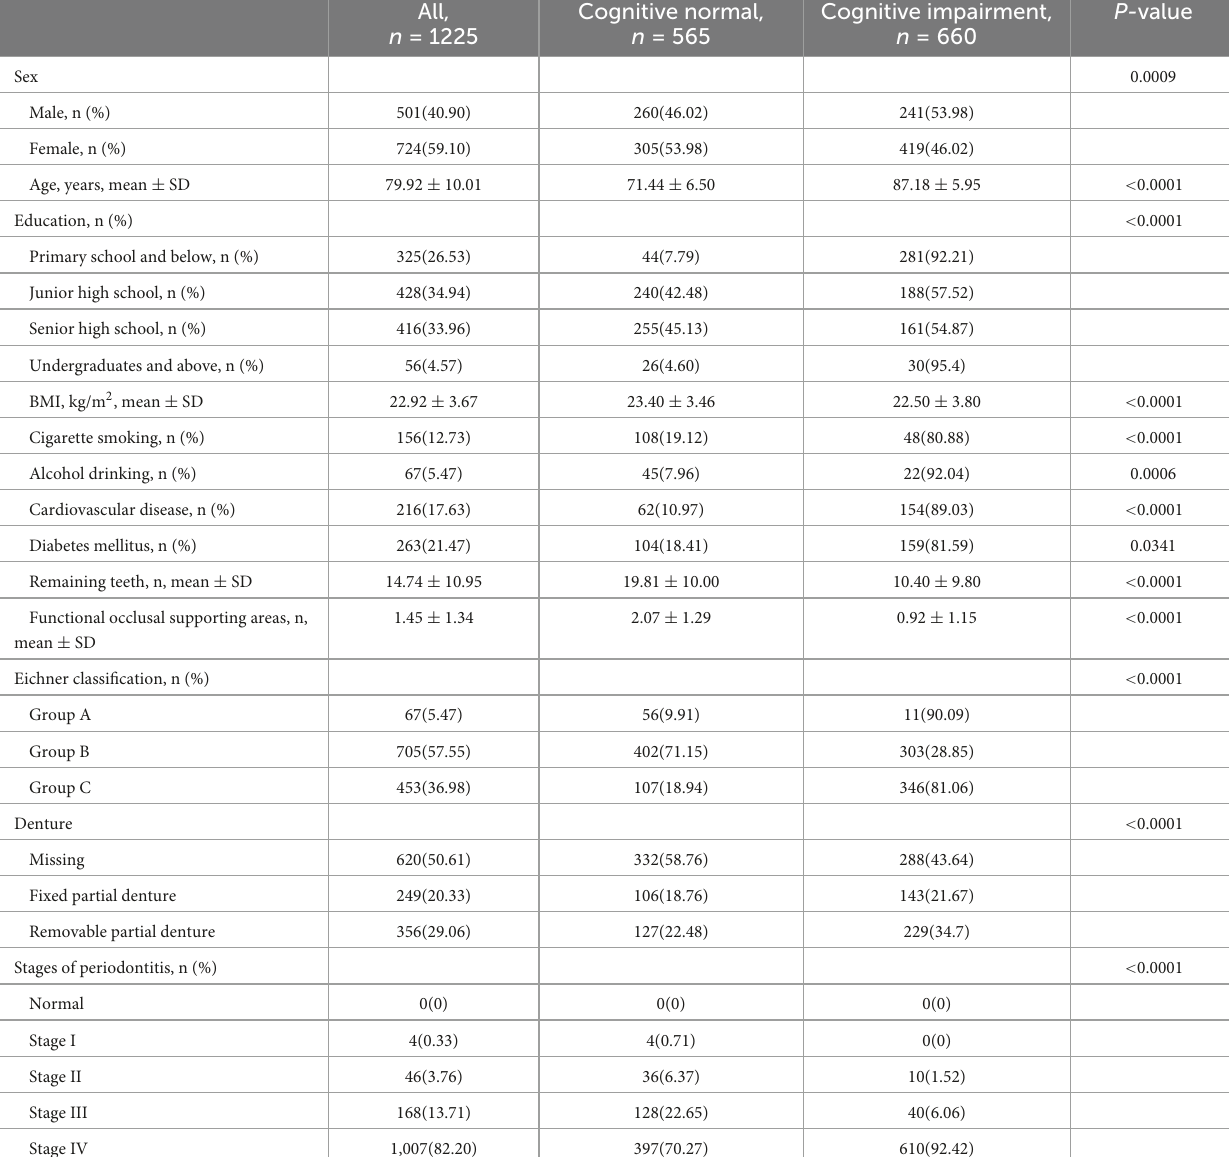
TABLE 1 Demographics of participants with or without cognitive